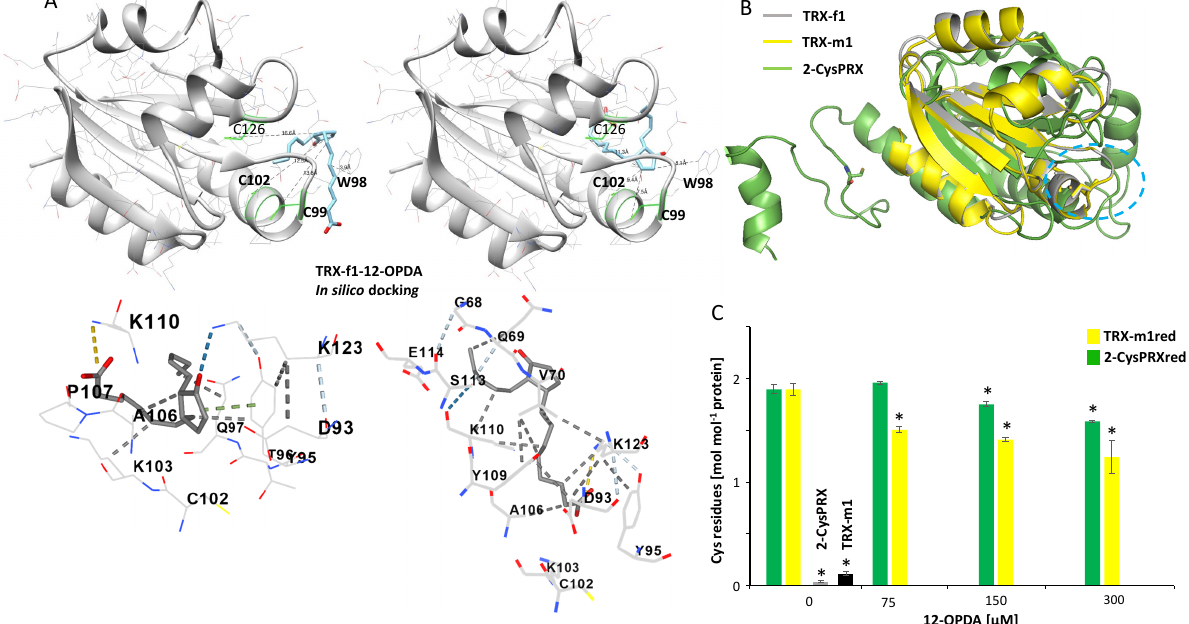
Figure 6. Modeling major TRX-fold proteins as 12-OPDA targets. ( A ) Models of the two best scored in silico docking results of TRX-f1 probed with 12-OPDA. The tertiary structure of TRX-f1 (grey) obtained by homology modeling based on TRX-f1 model PDB: 2PU9. The protein consists of five beta-strands and three alpha-helices. The 12-OPDA-binding region is suggested to be located in proximity to the active site Cys and Trp98. The left view suggests that Trp98 of TRX-f1 positions within 5 Å distance of the octanoic acid side chain of 12-OPDA, while the right view suggests that Cys 102 is 5.4 Å close to the electrophilic center of 12-OPDA. 12-OPDA is shown as blue stick model. Distances of sulfur atoms towards ß-C of 12-OPDA are indicated as dashed lines. Docking and visualization were performed using the online server SwissDock and the free accessible software package UCSF Chimera. The two graphics below show the first two top scoring docking results of TRX-f1 with 12-OPDA performed with CB-Dock. Suggested 12-OPDA (shown in gray stick presentation) binding cavities (sizes of 84 (left) and 153 (right), Vina scores of -5.5 (left) and -5 (right) with involved sidechains are shown as stick model. ( B ) Protein structure overlay of TRX-f1 with TRX-m1 (gray and yellow, both models based on 2PU9) and 2-CysPRX (PDB: 5ZTE, green) revealed that TRX fold and nucleophilic Cys residues (represented as sticks) structurally align within less than 5Å root-mean-square deviation of atomic positions. Suggested 12-OPDA binding site is highlighted. ( C ) Free thiols of untreated (2-CysPRX and TRX-m1), reduced (2-CysPRXred and TRX-m1red) and reduced proteins treated with 12-OPDA at different ligand concentrations. Asterisks indicate significant difference ( p ≤ 0.05) in comparison to control, calculated using one-way ANOVA with post hoc Tukey